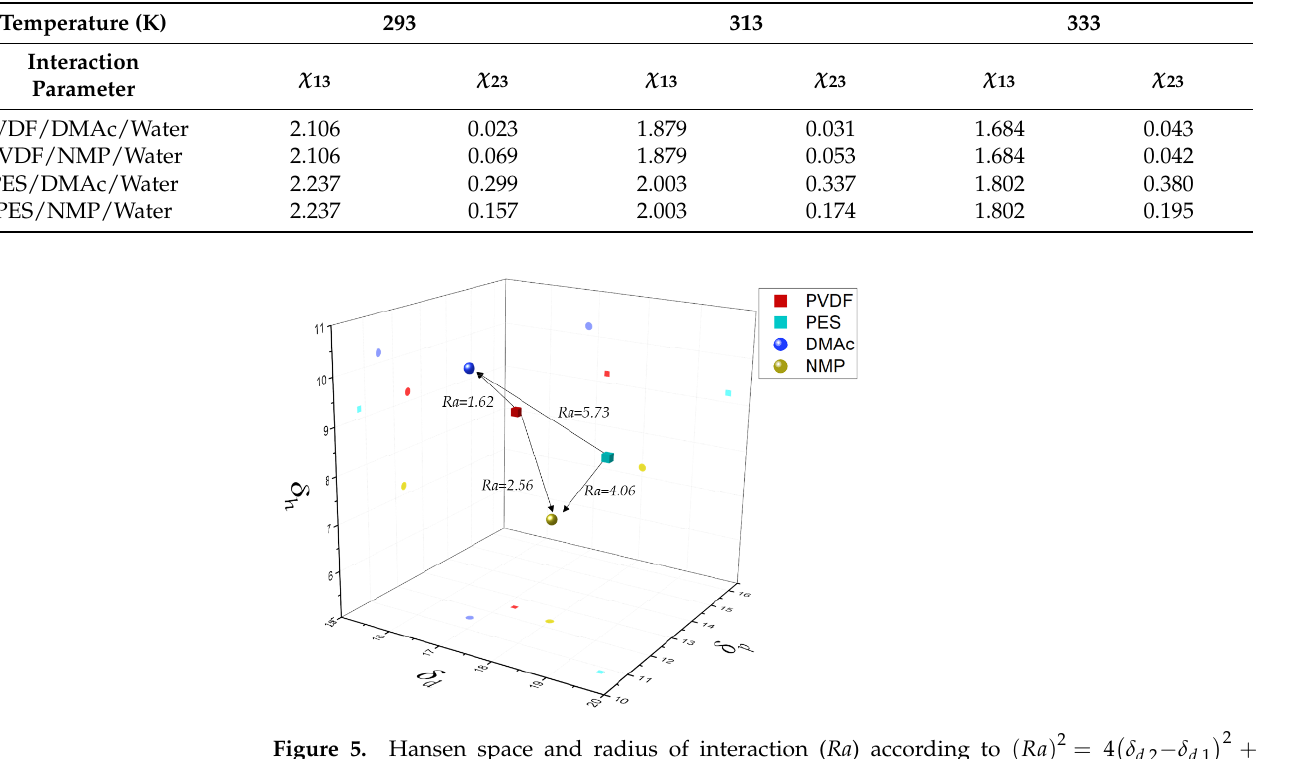
Figure 5. Hansen space and radius of interaction ( Ra ) according to ( Ra ) 2 = 4 ( δ d,2 - δ d,1 )